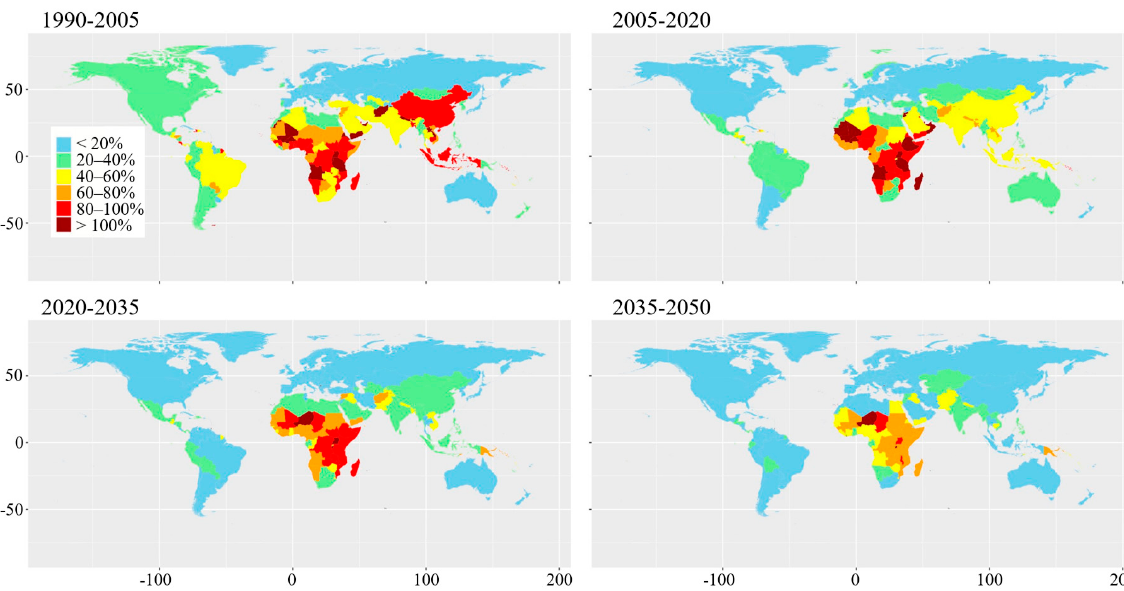
Figure 2. Global urban population growth, 1990–2005, 2005–2020, 2020–2035,